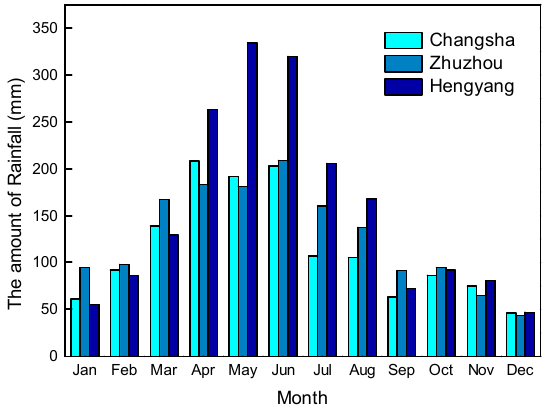
Figure 3. Average monthly rainfall for five years (2011–2015).